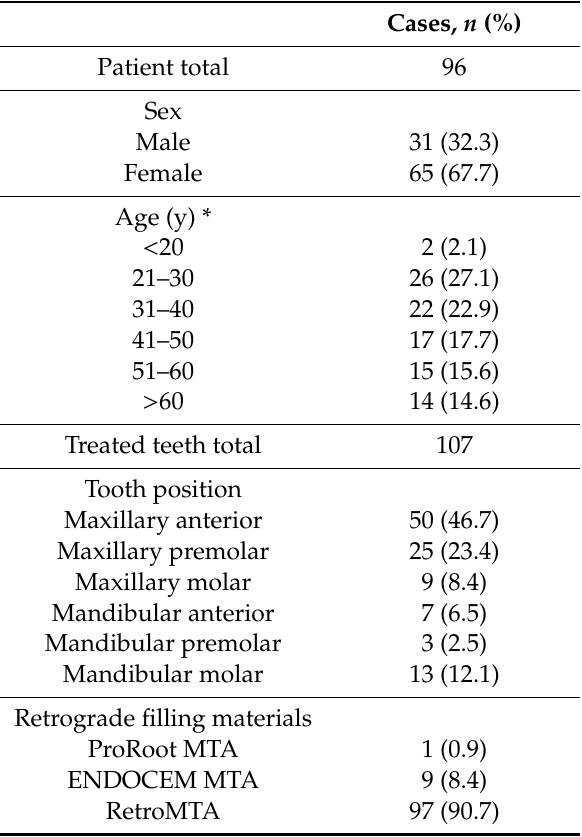
Table 2. Case distribution of patients ( n = 96) and treated teeth ( n = 107).